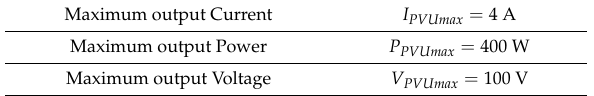
Table 2. Electrical characteristics of the proposed Boost based PVU